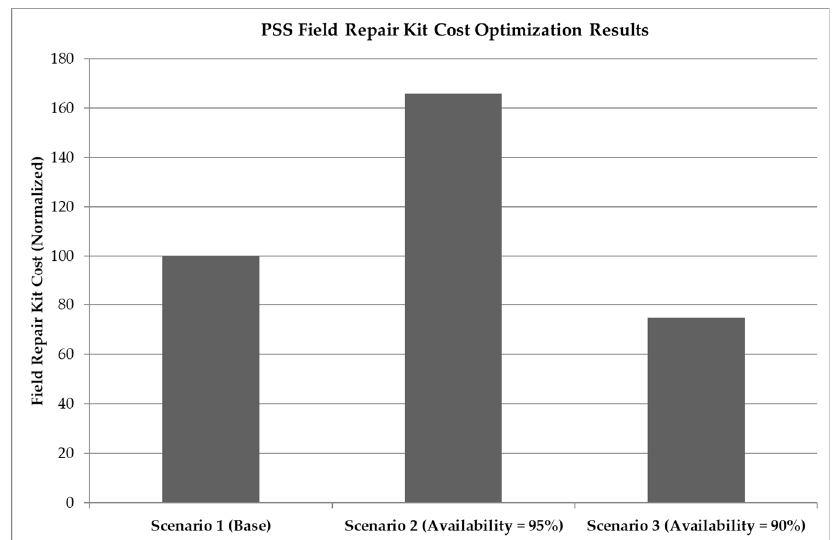
Figure 4. Field repair kit cost optimization results for scenarios analyzed.